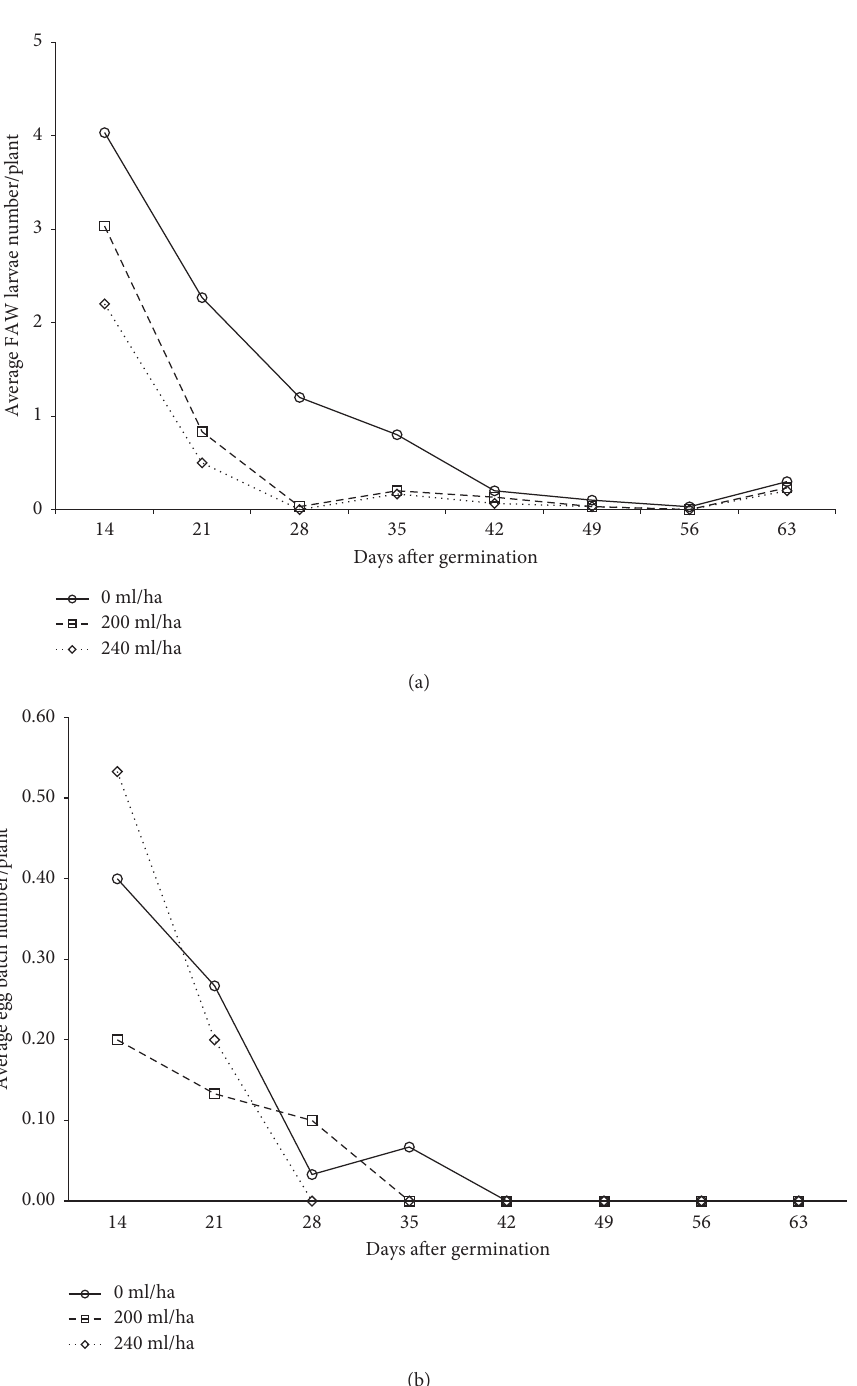
Figure 1: A graph showing (a) fall armyworm larvae and (b) egg batches number counted on maize leaf and whorl during the sampling days for Ampligo applied at rates of 0ml/ha, 200ml/ha, and